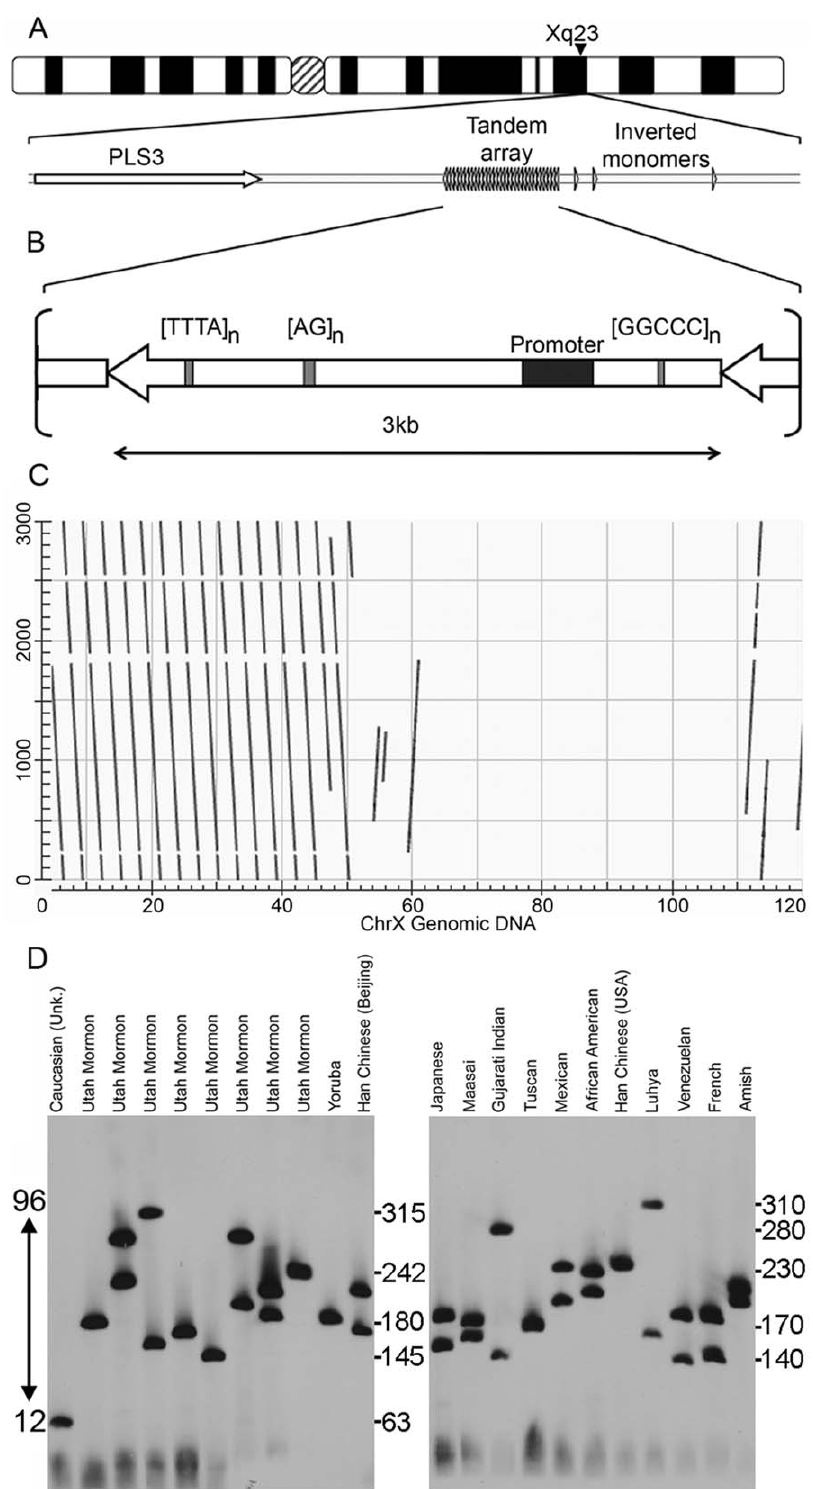
Figure 1. Organization and variation of DXZ4. (A) Ideogram of the human X chromosome showing the location of DXZ4 at Xq23. Beneath this is a schematic representation of the region immediately surrounding DXZ4. The macrosatellite array and distal inverted monomers are represented by the arrow heads. The nearest gene PLS3 is indicated proximal to the array. (B) Representation of a single 3.0 kb DXZ4 monomer defined by Hind III. The internal microsatellite repeats are indicated as is the DXZ4 promoter region. (C) Predicted higher-order organization of the array as revealed by dot-plot analysis. A single 3.0 kb monomer sequence is on the y-axis, whereas the 120 kb genomic interval containing the array and inverted monomers is on the x-axis. The 120 kb sequence is located at 114.9 Mb on the human X chromosome (coordinates according to build hg19). Dot- plot generated using NCBI Blast, and the output image labeled in Adobe Photoshop CS2. (D) Copy number variation of DXZ4. Southern blot analysis